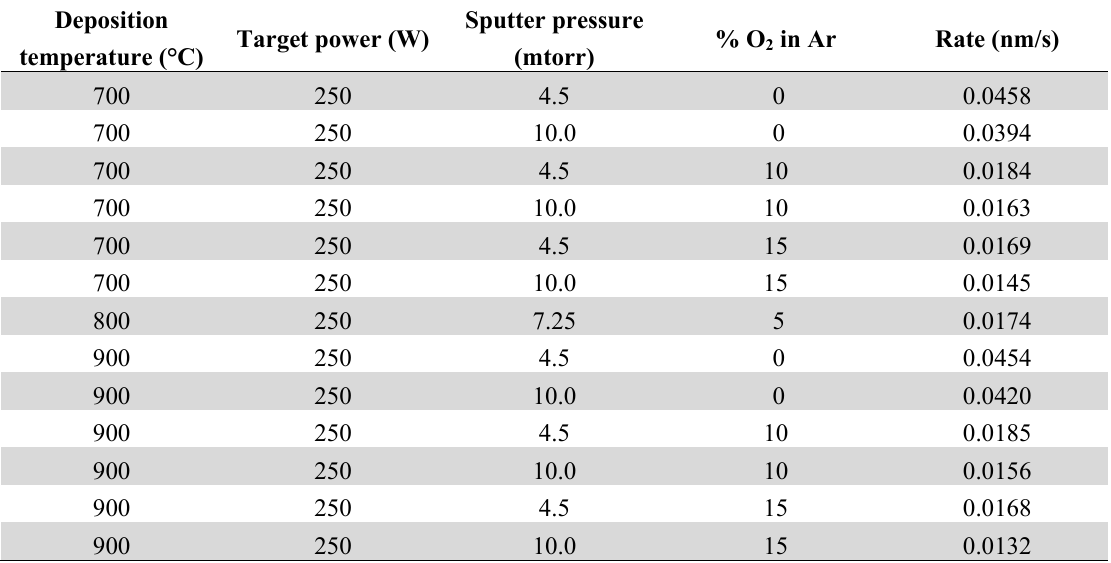
Table 1. Deposition conditions and rates for BCZTO sputtered thin-films.